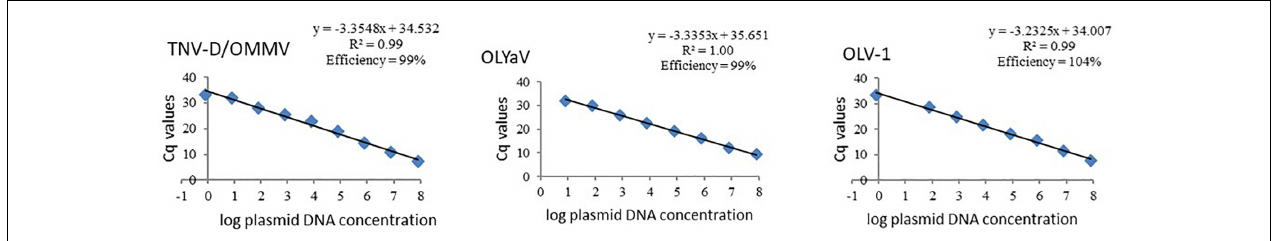
FIGURE 1 | Standard curves of olive viruses constructed based on Cq values obtained from a ten-fold dilution series of each target plasmid DNA in the dynamic range of 0.8 to 8E7 target copies. TNV-D, Tobacco necrosis virus ; OMMV, Olive mild mosaic virus ; OLV-1, Olive latent virus 1 ; OLYaV, Olive leaf yellowing-associated virus ; R 2 , regression